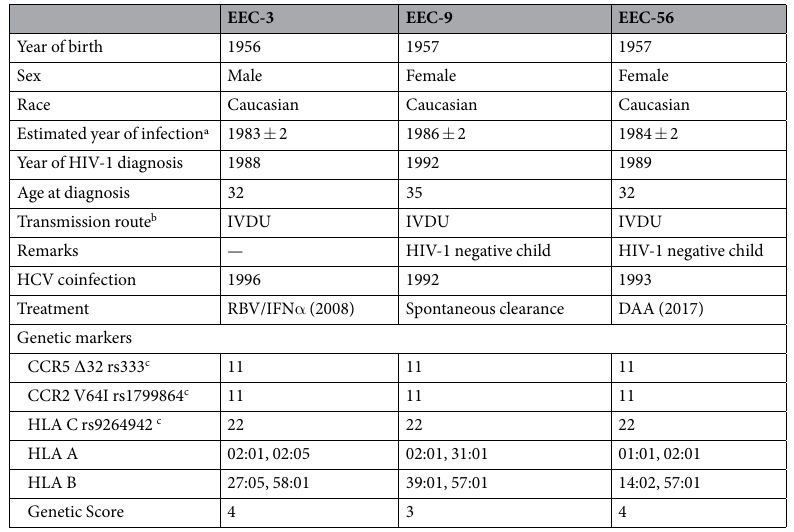
Table 1. Clinical, epidemiological and host-genetic characteristics. a Viral dating performed in the last sample and estimated according to 17 . b No further expositions after HIV-1 diagnosis. c “1” indicates the most frequent allele and “2” the mutant. IVDU, intravenous drug user; RBV, ribavirin; IFN α , interferon α , DAA, direct acting